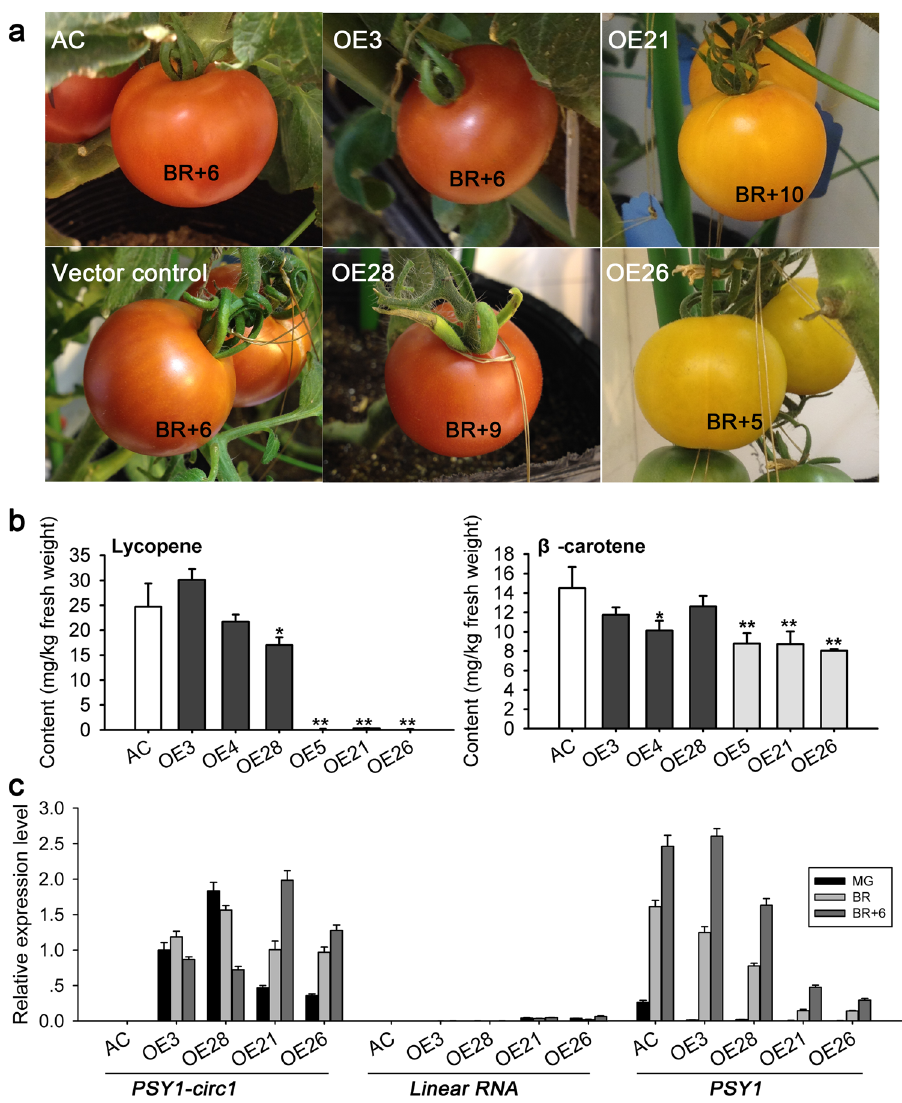
Figure 4. Overexpression of PSY1-circ1 in Ailsa Craig. ( a ) Fruits of different PSY1-circ1 overexpression tomato lines. OE3-OE28 stand for transgenic lines. Vector control stands for Ailsa Craig (AC) plants transformed with the empty vector pCAMBIA1301. ( b ) Lycopene and β -carotene contents in transgenic tomato fruits at breaker + 10 stage. White, black and gray bars stand for control, transgenic lines with red fruits and yellow fruits respectively. The data with error bars were expressed as mean ± SEM (Standard Error of the Mean, n = 4), asterisks indicate statistically significant difference (with respect to control; * p value < 0.05; ** p value < 0.01; two-way ANOVA followed by LSD (Least Significant Difference) test). ( c ) Expression profile of PSY1-circ1, linear RNAs generated by the overexpression vector, and PSY1 gene in transgenic tomato fruits at different ripening stages. The data are normalized to Actin and presented as means ± SD (n =